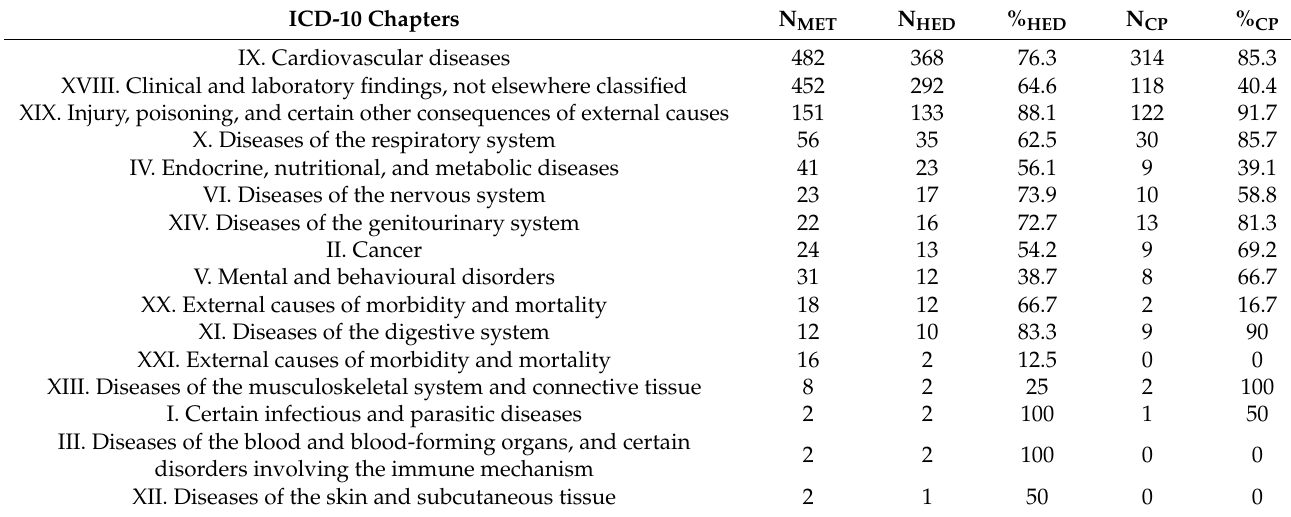
Table 6. Percentage of patients transported to HED by MET diagnosis according to ICD-10 Chapters.